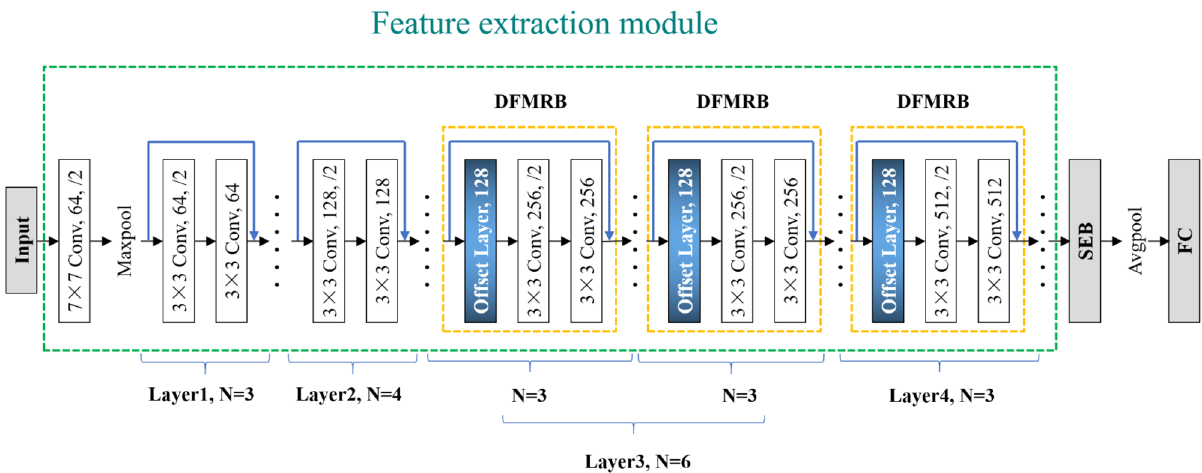
Figure 8. Diagram of deformable feature map residual